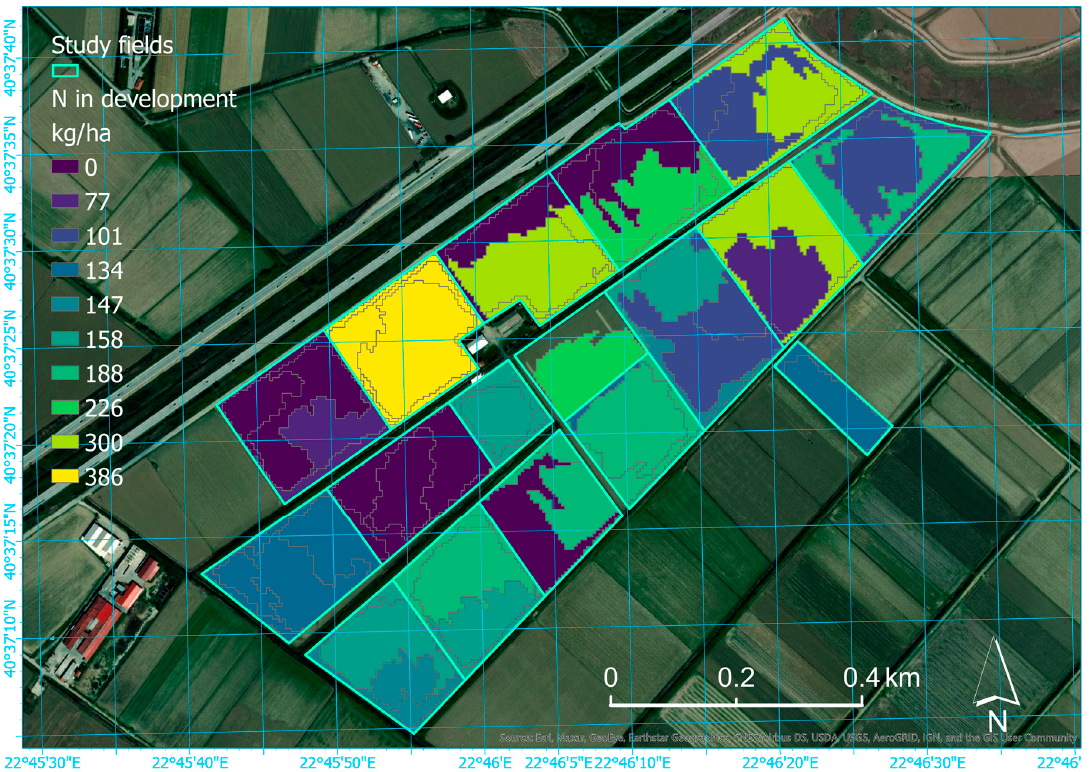
Figure 14. An indicative map of nitrogen recommendations at the development phase for the central sector of the studied rice farm; zones with zero values were managed with different types of fertilizer.